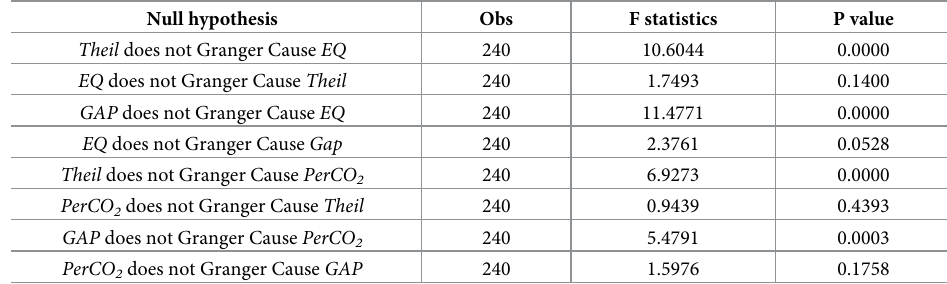
Table 2. Granger non-causality test results.